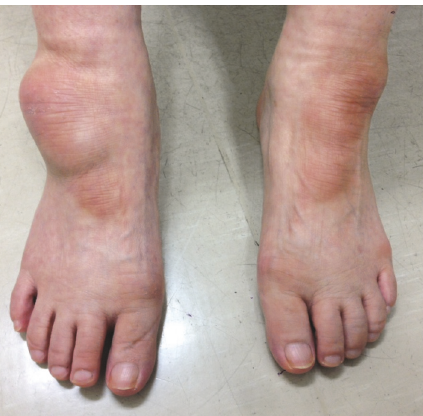
Figure1:Theappearanceoftheanklesbeforesurgery.Theanterolat- eral area of the right ankle was swollen and had an overlying callus. A callus may also be seen in the same position in the left